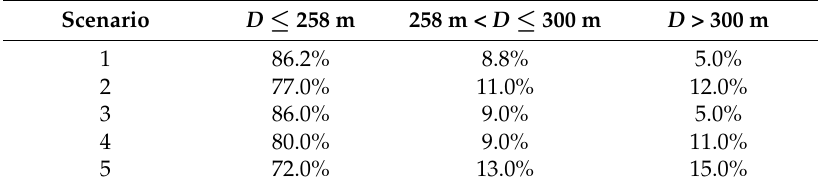
Table 3. Distribution, in percentage, of the quantity of individual trees in each class of extraction distance ( D ) by